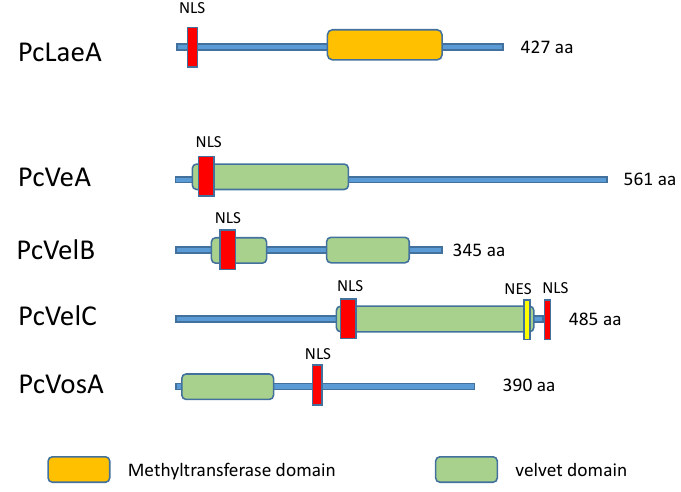
Figure 7. Conserved domains in PcLaeA, PcVeA, PcVelB, PcVelC, and PcVosA. Predicted nuclear localization signals (NLS, red) and putative nuclear export sequences (NES, yellow) are also indicated (adapted from [183]).